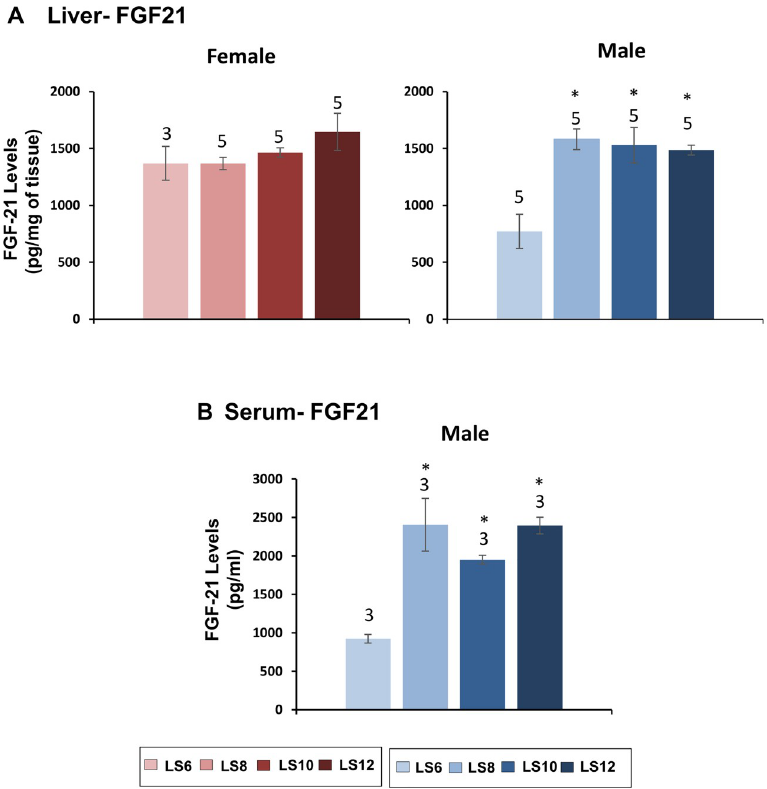
Fig 7. Effect of litter expansion on FGF21 levels. The protein levels of FGF21 in the liver (A) of female and male mice and serum (B) of male mice were measured at 15 months of age. Data represented are the mean ± SEM from 3–5 mice per group. All groups were compared to control LS6 and were statistically analyzed by one-way ANOVA with Tukey’s and FDR with Benjamini & Hochberg multiple correction test ( � p < 0.05).